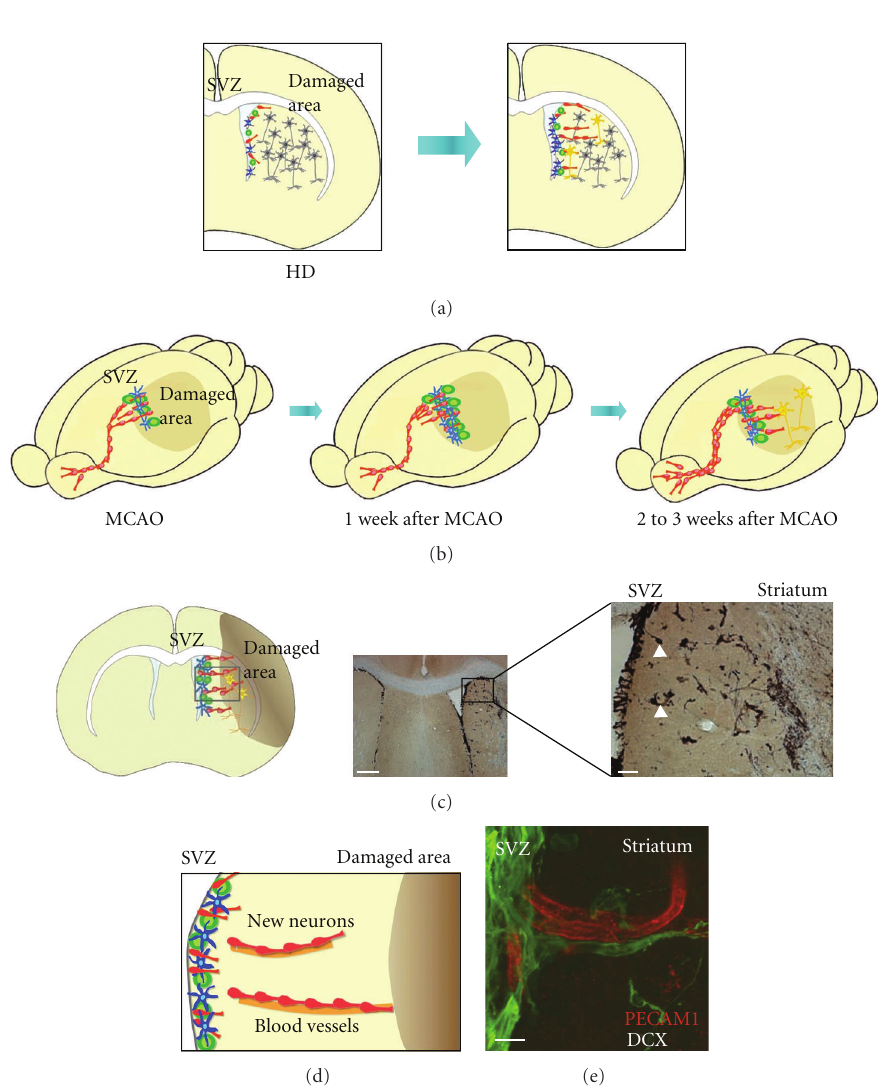
Figure 2: Neurogenesis after neuron loss. (a) Spontaneous neuronal regeneration in HD. In parallel with the progressive degeneration of striatal neurons caused by HD, the production of new neurons in the SVZ increases significantly.These new neurons migrate into the a ff ected striatum, where only some di ff erentiate into mature neurons. (b) Migration of new neurons toward the damaged area in the mouse MCAO model. MCAO causes an infarction in the striatum and adjacent parietal cortex. Within a week of the insult, neural stem cells (blue) and transit-amplifyingcells (green) in the SVZbegin to proliferate, and by two or three weeks after MCAO, new neurons (red) migrate and appear at the border of the damaged area in the striatum. (c) At left, a schematic drawing of the coronal brain section 18 days after MCAO. At right a section immunostained for DCX. Boxed area is shown at higher magnification at far right. Many new neurons migrate into the ipsilateral striatum, but not the contralateral striatum. Some new neurons migrate into the striatum in chain-like clusters (far right, arrowheads). Scale bars: left, 500 μ m; right, 200 μ m. (d) Schematic drawing of new neurons migrating along blood vessels toward the damaged striatum. (e) Confocal projection image of new neurons migrating along blood vessels, in a coronal brain section, 18 days after MCAO. The section was immunostainedfor DCX (green) and an endothelial cell marker, PECAM-1 (red). Scale bar: 50 μ m. MCAO, middle cerebral artery occlusion; SVZ, subventricular zone; OB, olfactory bulb; DCX, doublecortin; PECAM-1, platelet endothelial cell adhesion